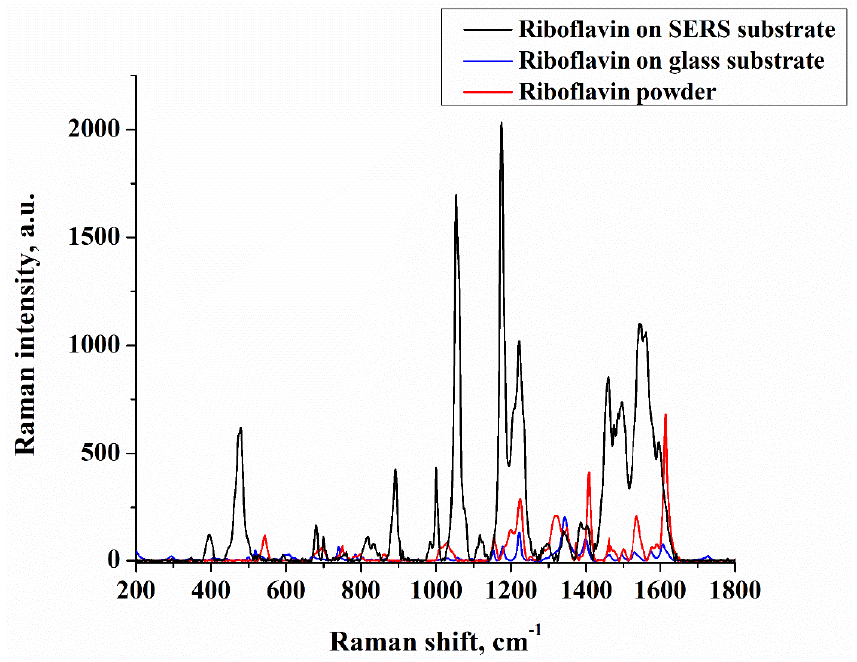
Figure 2. Raman spectra of riboflavin measured on gold nanoislands SERS and pure glass substrates, and in solid form.